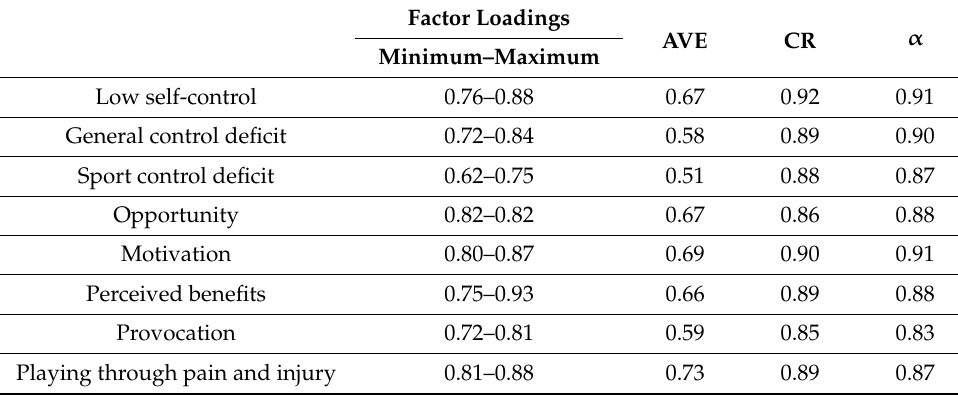
Table 1. Validity and reliability of research measurement